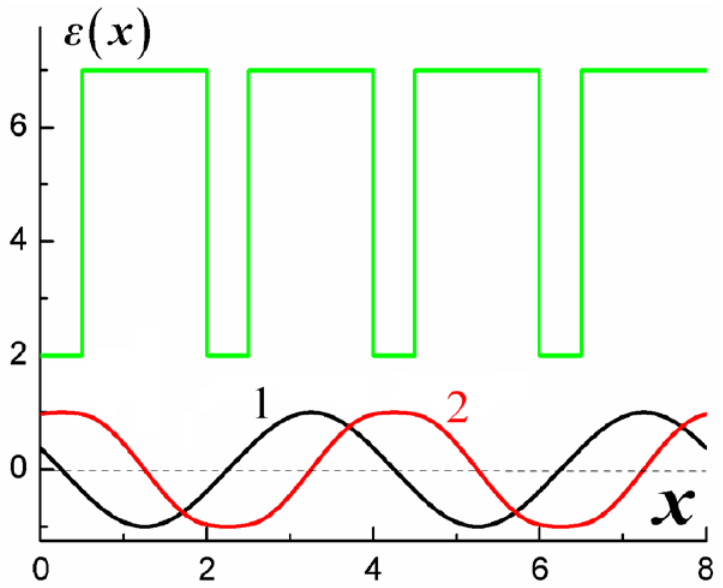
Figure 13. The results of computer simulation: the amplitude of the electric field distribution for a Bloch wave in a PC at frequencies near band edges: 1 —below a BG and 2 —above a BG. The curve at the top is the function ( ) x ε